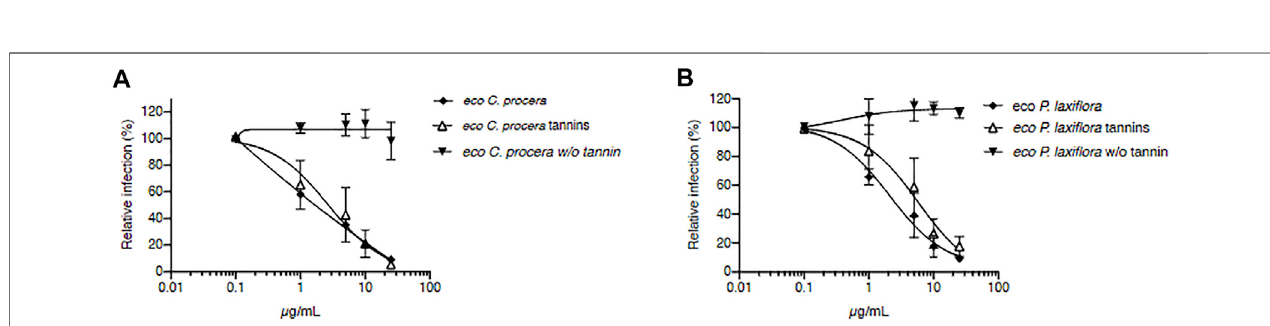
FIGURE5| Tannin-richeco-extractsof C.procera and P.laxi fl ora areactiveagainstHCV. C.procera (A) and P.laxi fl ora (B) eco-extracts(50%ethanol)weretested on HCV infection before tannin removal and before heating (squares), after heating (triangles), and after tannins removal (w/o tannins). Quanti fi cation of infection was as described above. Data are presented relative to untreated control. Data are means ± SEM of 3 experiments performed in triplicates.